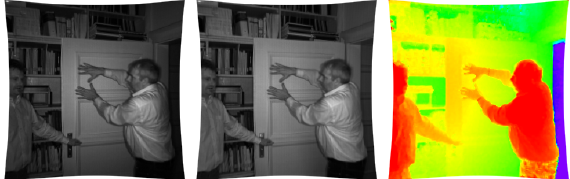
Figure 4: Visualization of the undistorted images for normalized active intensity, normalized passive intensity and range informa- tion (from left to right).